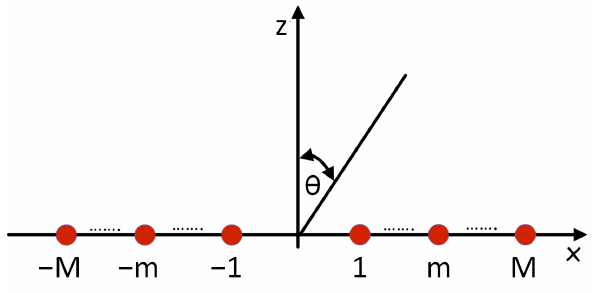
Figure 5. Schematic diagram of the geometry in a linear antenna